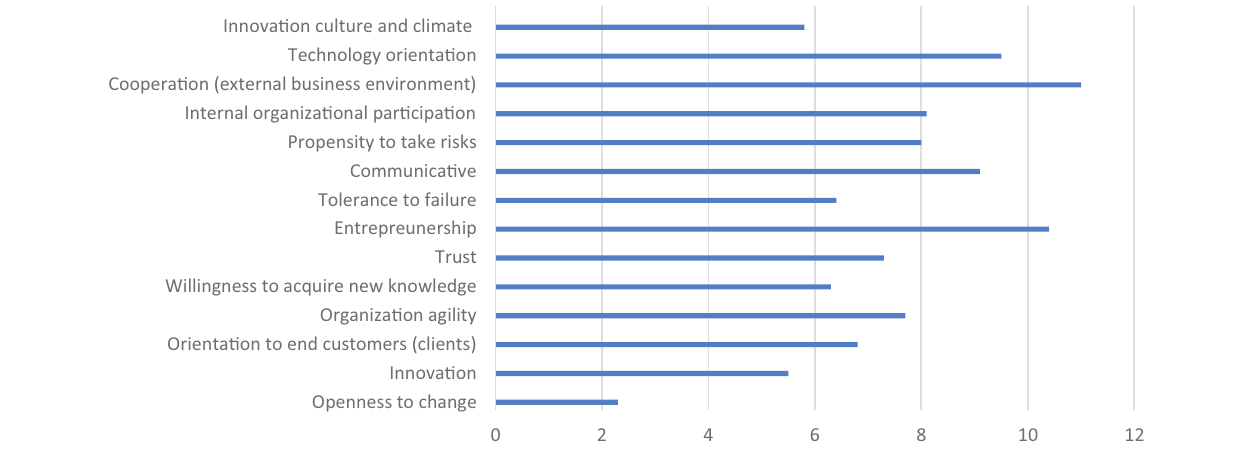
FIGURE 4 | Cultural values by relevance, ranked from 1 (most relevant) to 12 (least relevant) in terms of their contribution to disruptive innovations in a changing environment ( n = 49; source: